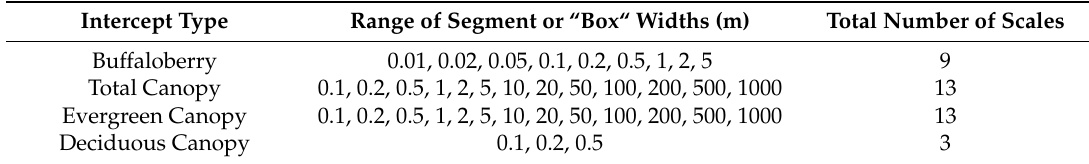
Table 1. Number and width (m) of box-counting segments used for fractal dimension calculations for buffaloberry shrubs and forest